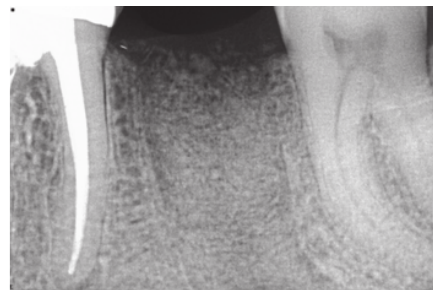
Figure 15: Following socket grafting—healing at 3 months.